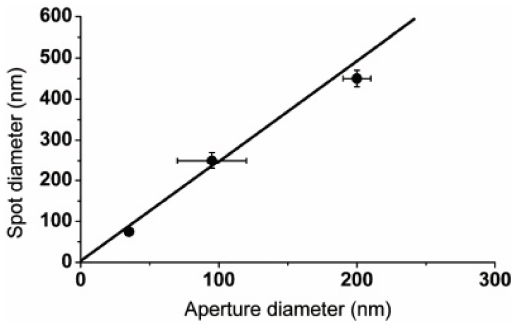
Figure 15. The spot sizes obtained for various aperture diameters deposited by a hydrophobic tip on a hydrophobic amine substrate surface with various aperture diameters made on the tip apex (NADIS). Reprinted with permission from [118].